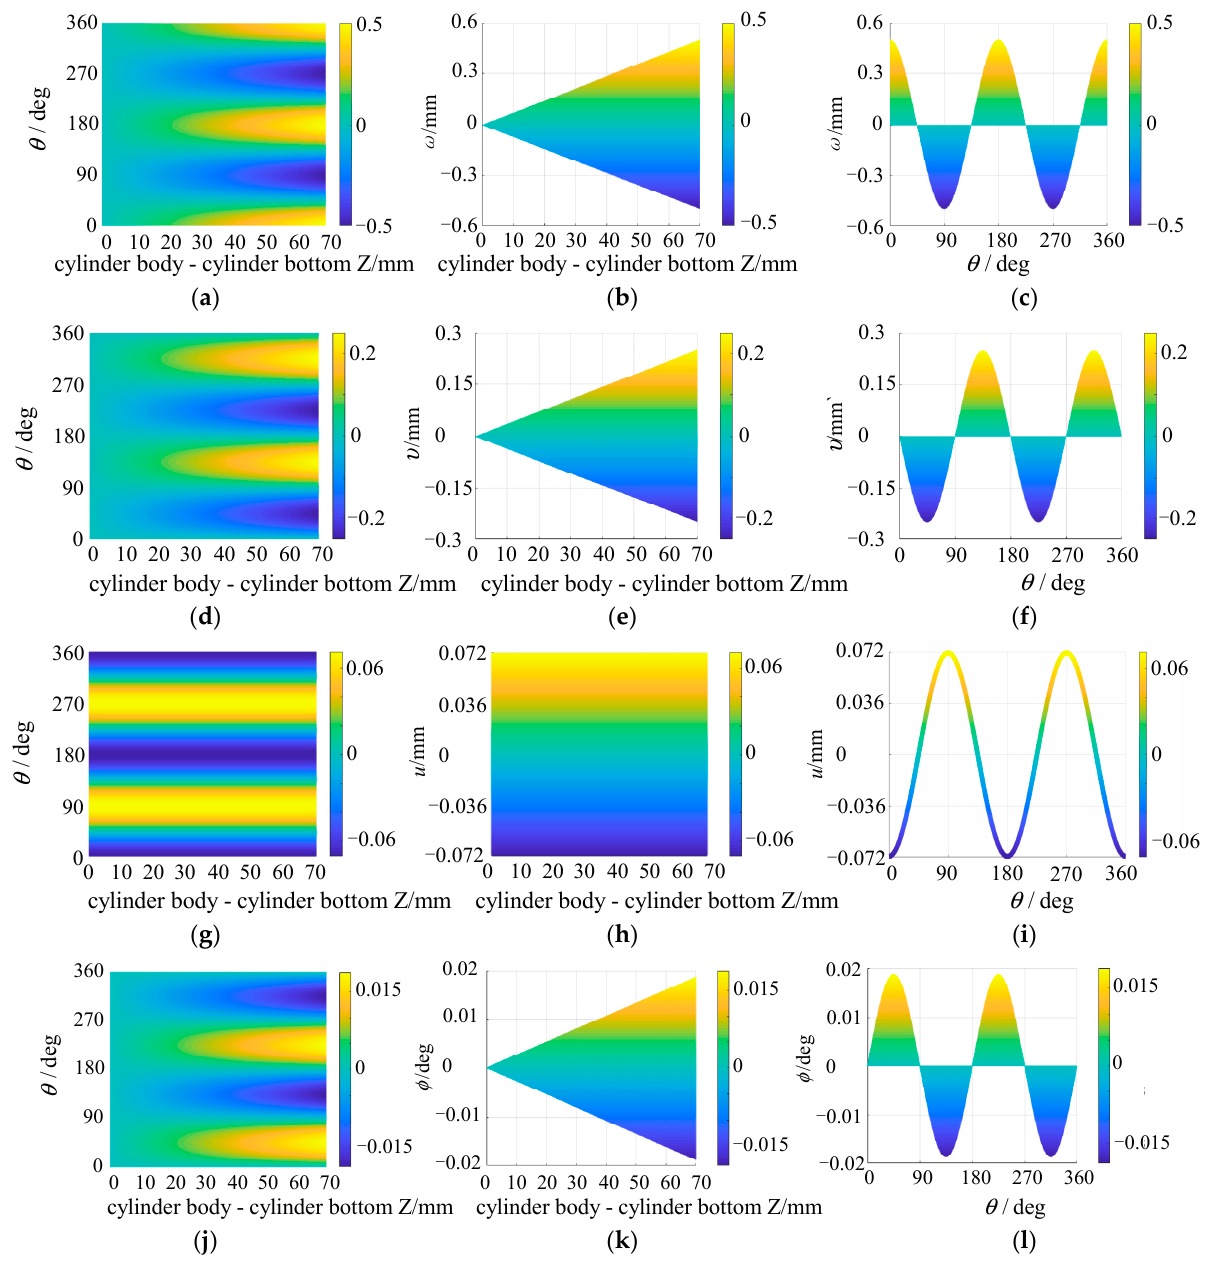
Figure 12. Flexible wheel displacement plane projection. ( a ) Radial displacement xoy; ( b ) Radial displacement xoz; ( c ) Radial displacement yoz; ( d ) Circumferential displacement xoy; ( e ) Circumferential displacement xoz; ( f ) Circumferential displacement yoz.; ( g ) Axial displacement xoy; ( h ) Axial displacement xoz; ( i ) Axial displacement yoz; ( j ) Angular displacement xoy; ( k ) Angular displacement xoz; ( l ) Angular displacement yoz.